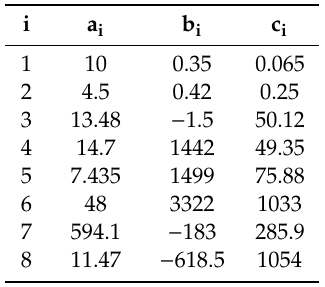
Table 1. Parameter a i , b i and c i